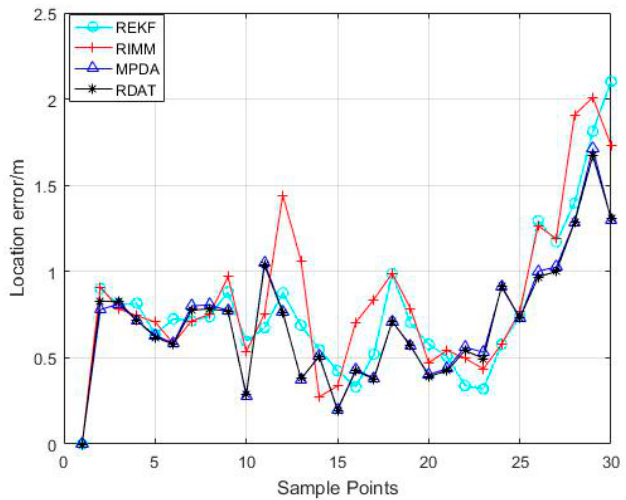
Figure 12. The localization error of sample points.